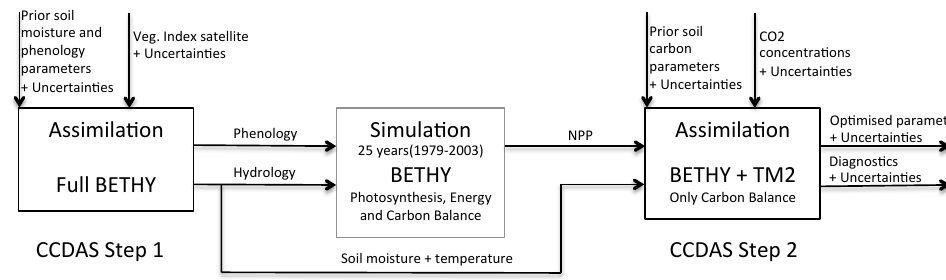
Figure 1. CCDAS structure. Top arrows indicate the parameters to be optimised and the observational data used in the various